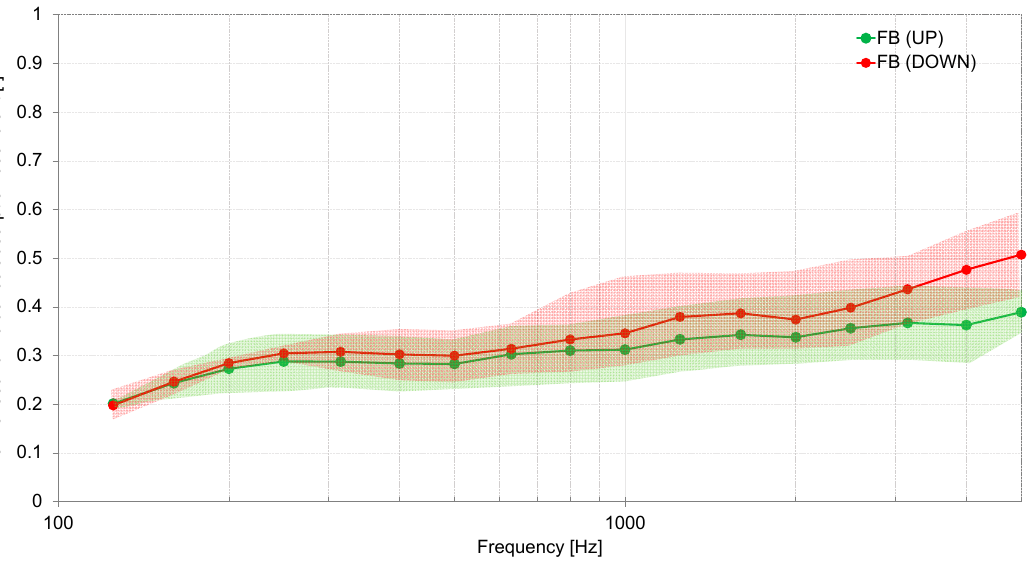
Figure 9. Normal incidence sound absorption coe ffi cients experimentally measured (SP mix).